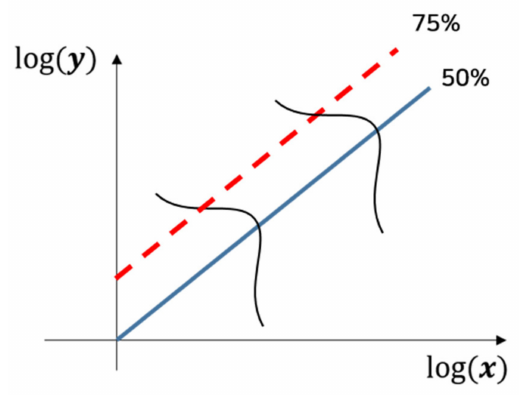
Figure 7. Concept of 75% coverage